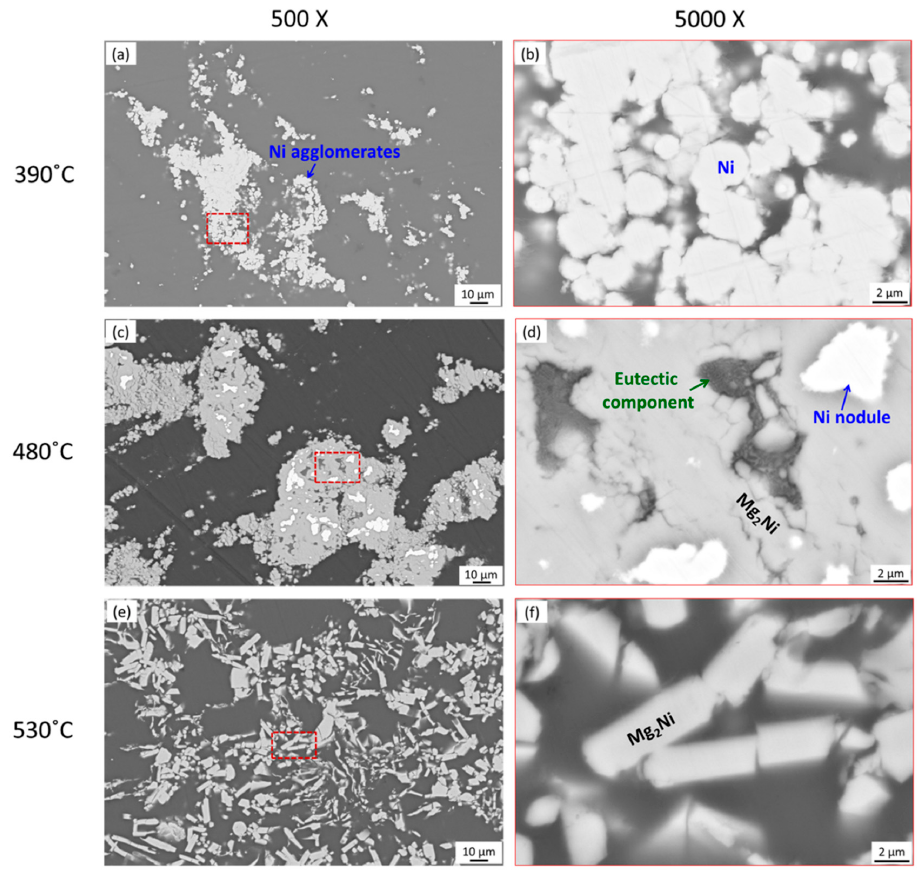
Figure 8. Back-scattered SEM images of the surface perpendicular to the forging direction of samples forged ( a , b ) at 390 °C; ( c , d ) at 480 °C; and ( e , f ) at 530 °C. forged ( a , b ) at 390 ◦ C; ( c , d ) at 480 ◦ C; and ( e , f ) at 530 ◦